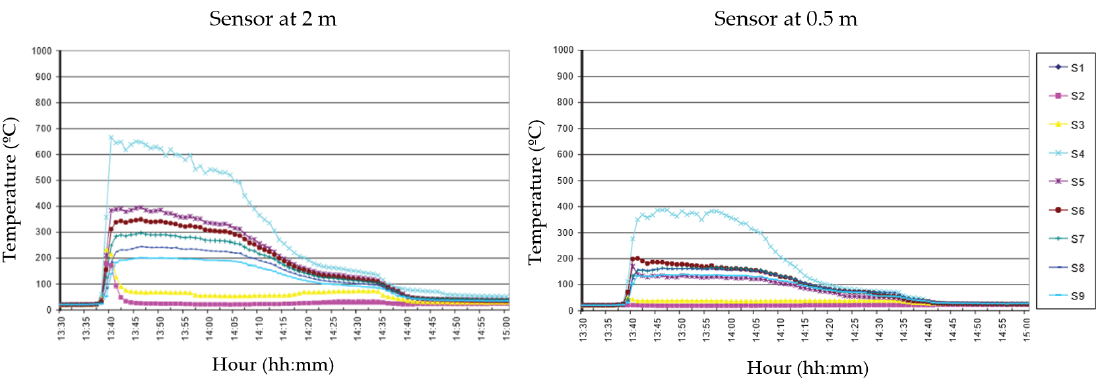
Figure 13. Evolution of the temperature along the drift at different heights; scenario 4.